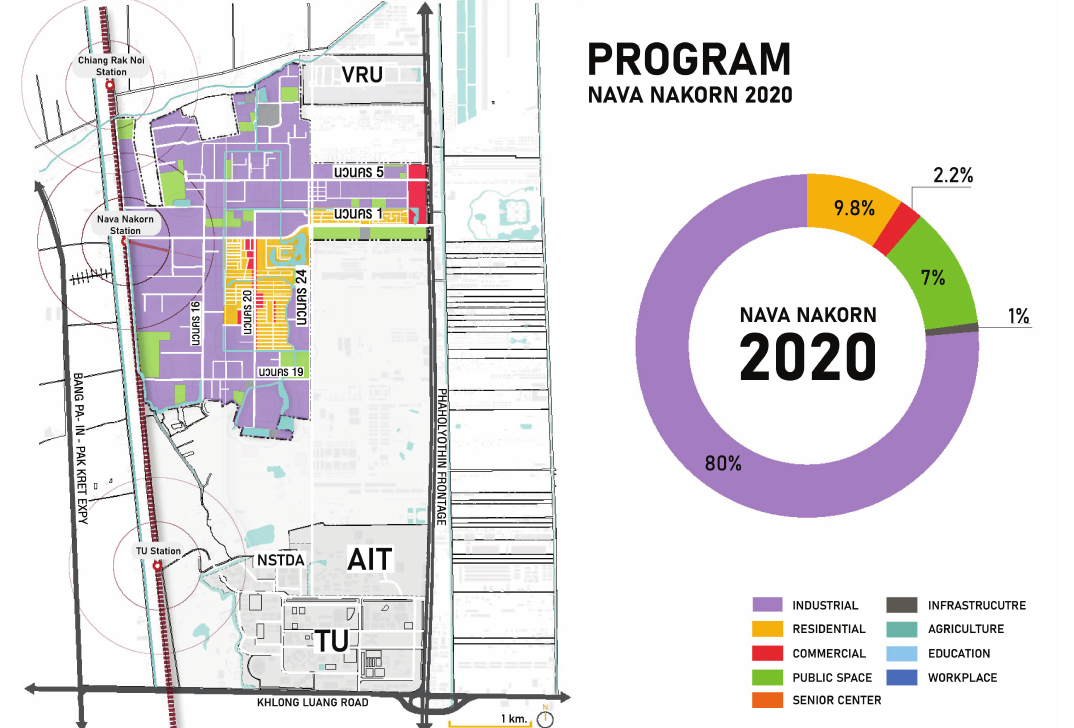
Figure 3. Land use in the VRU/Nava Nakorn/Thammasat University corridor of the superblock, 2020. The white area between Nava Nakorn and AIT is idle land. Graphics credits to Thanakit Singduang, Thanyamon Traimittaparp, Areerat Joemkor, Kotchakorn Chaiyatum, Apicha Promnao, Thannicha Charoenwan, Thanawit Likhitworasak, Phatharamon Panon, Nanthicha Jiwatjanarodom, AR416